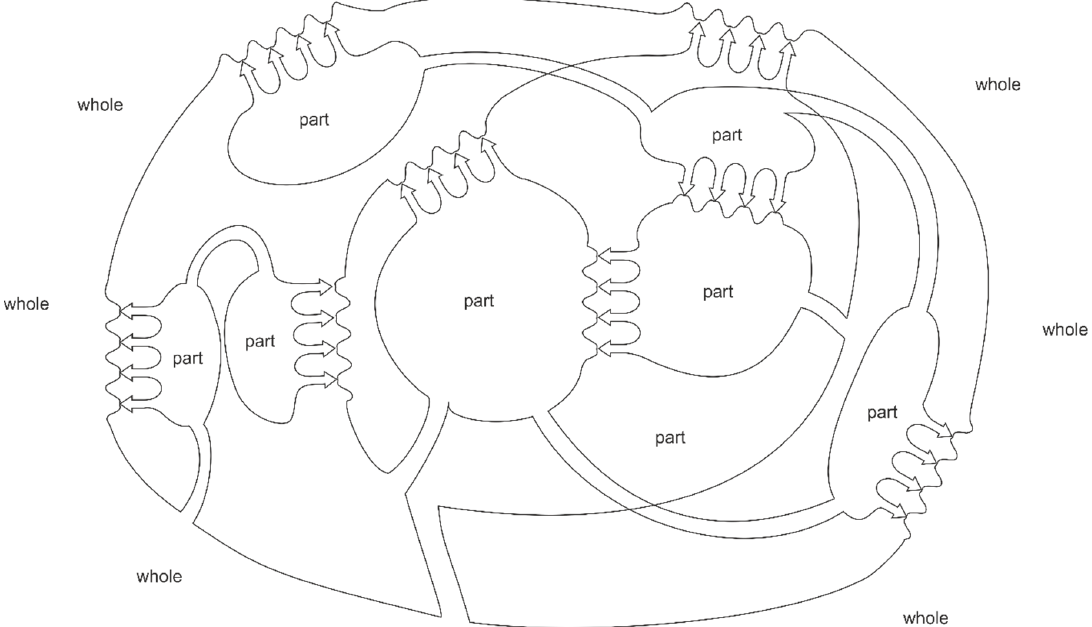
Figure 4. Simplified example of the structure of knowledge acquisition.